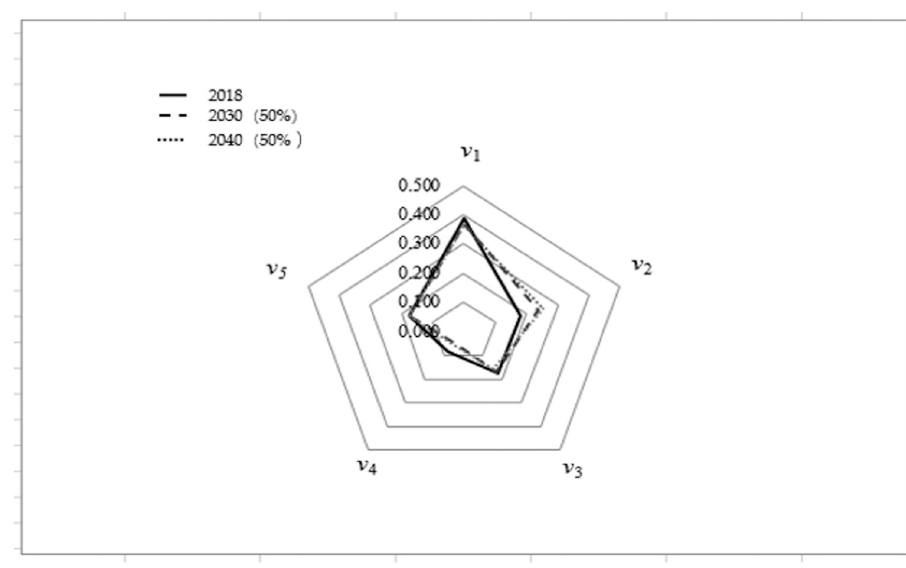
Fig 4. Comparison of evaluation grades for three years without water right